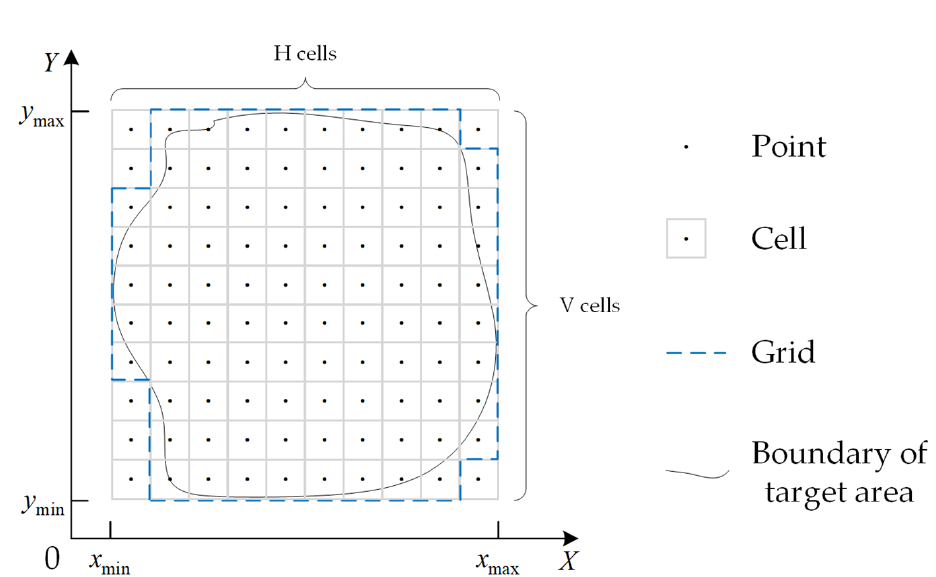
Figure 4. Schematic diagram of the grid space construction.